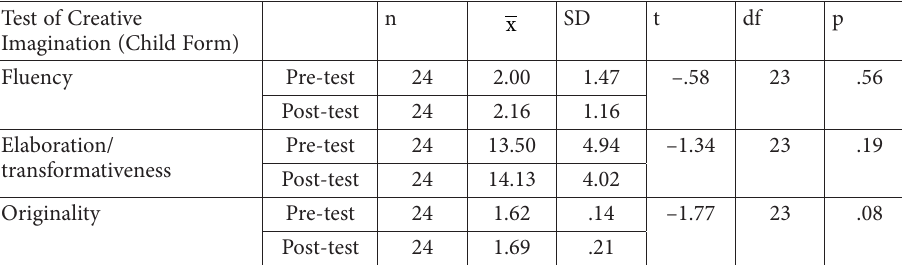
Table 2. Paired Samples T-Test results for pre-test and post-test mean scores of the children in the control group (source: created by author)